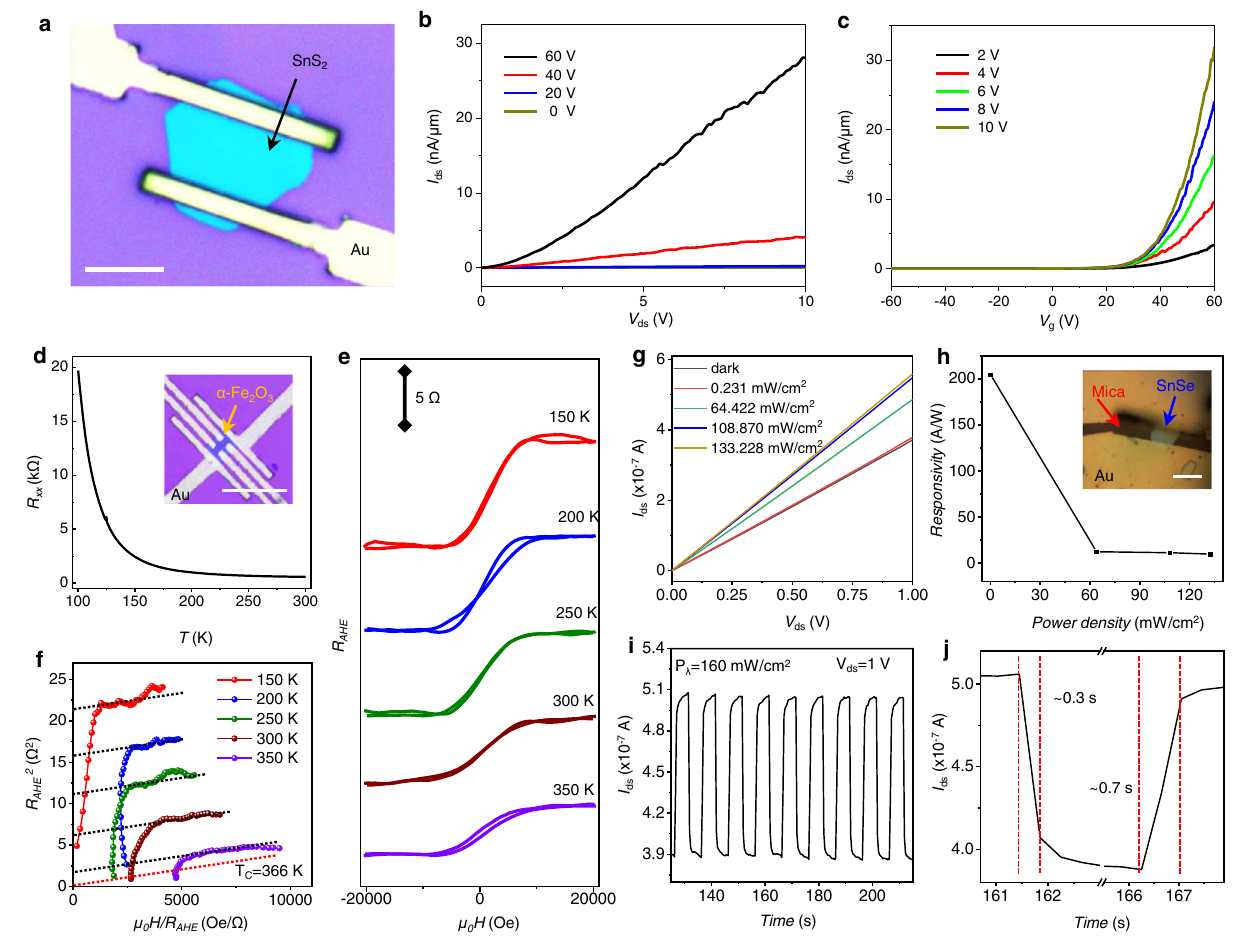
Fig. 6 | Electrical, Magnetic and optoelectronic characterizations of 2D nanosheet. a OM image of the SnS 2 FET device, Scale bar: 10 μ m. b Typical drain- source current ( I ds ) vs drain-source voltage ( V ds ) output characteristics of the SnS 2 FET measured under various gate voltages. c Typical transfer curves of the FET. d The longitudinal resistance ( R XX ) at different temperatures for α -Fe 2 O 3 nanosh- eet.TheinsetisOMimageoftheHallbardevice,Scalebar:30 μ m. e Theresistance ofanomalousHalleffect( R AHE )plottedasafunctionofthemagnetic fi eldatvarious temperature. f Arrott plots of the Hall resistance data of the α -Fe 2 O 3 nanosheet